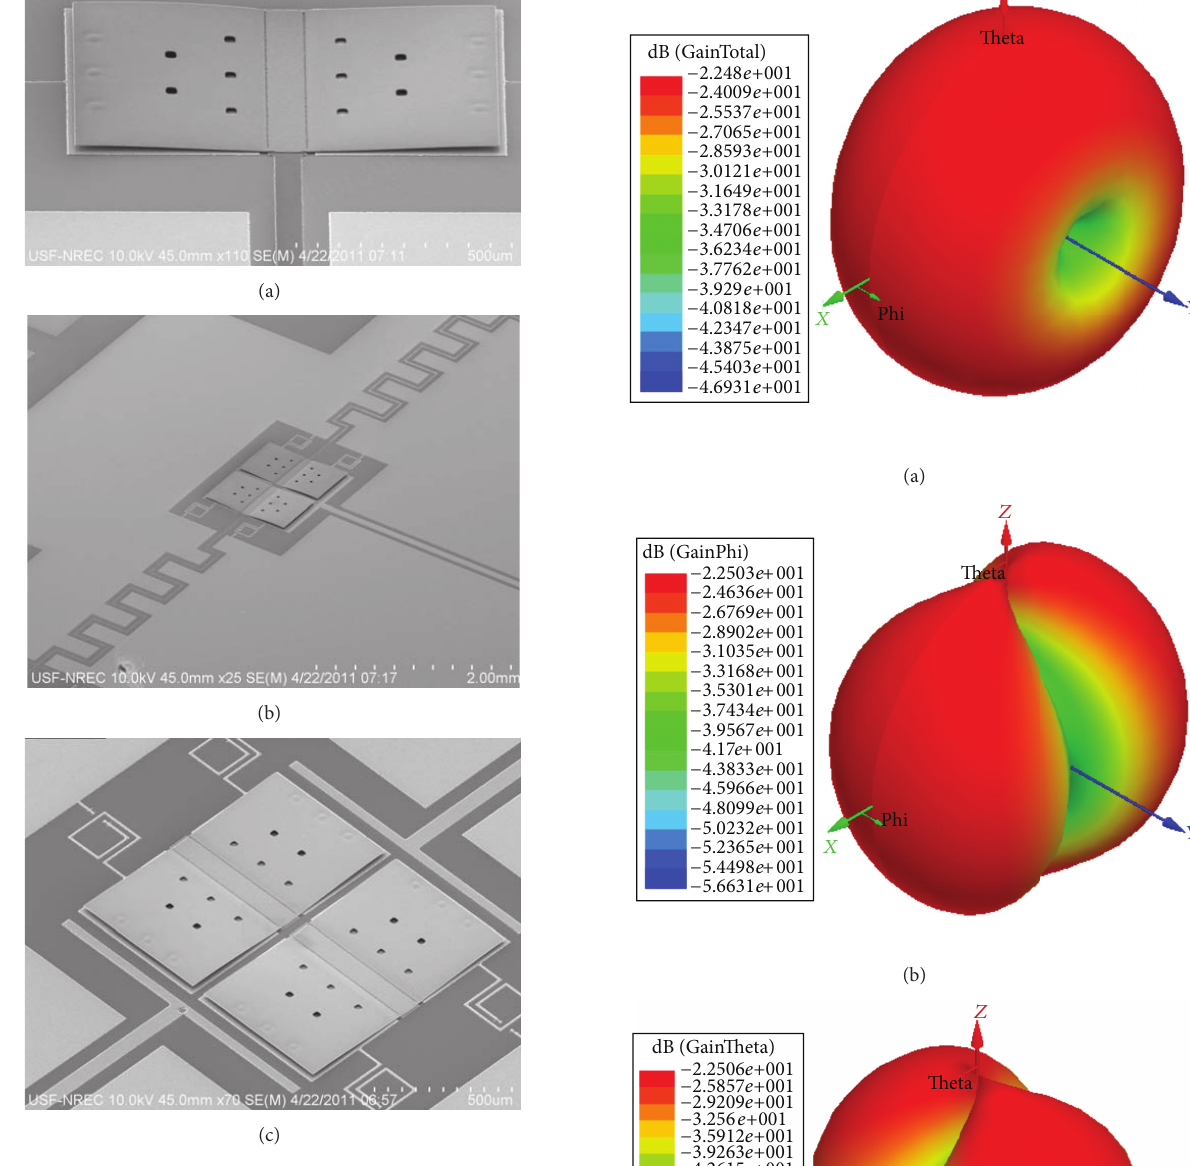
F 9: SEM photographs of (a) the MEMS capacitor, (b) a MEMS-MTM antenna basic cell, and (c) a ZOR resonator.